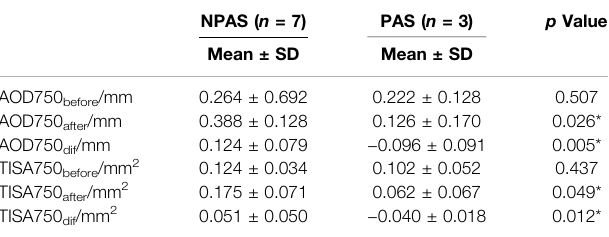
TABLE 3 | Comparisons of structural parameters between the NPAS and PAS groups before and after the air puff. NPAS ( n =